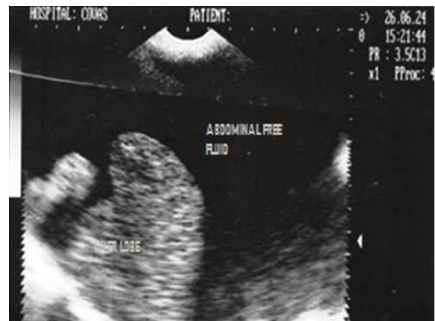
Figure 16: Right lateral radiograph of a 2-year-old castrated male mixed-breed dog with microhepatica. The stomach is distended with gas, which provides contrast with the liver shadow. Notice the proximity of the stomach to the diaphragm, implying reduced hepatic mass.